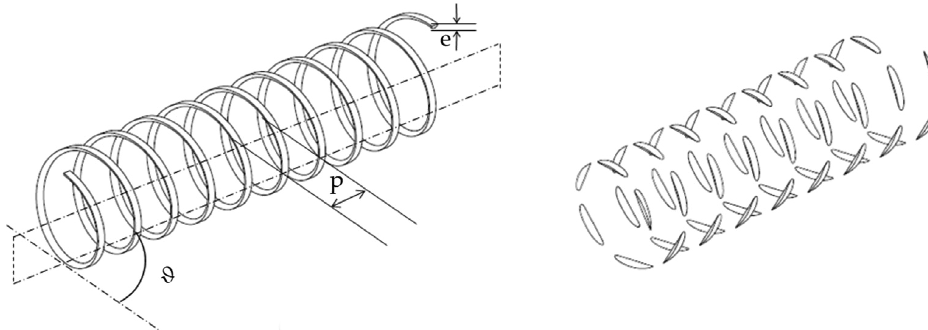
Figure 1. Schematics of the continuous helicoidal turbulator RIB-1 ( left ) and RIB-2 ( right ) from Virgillio et al.